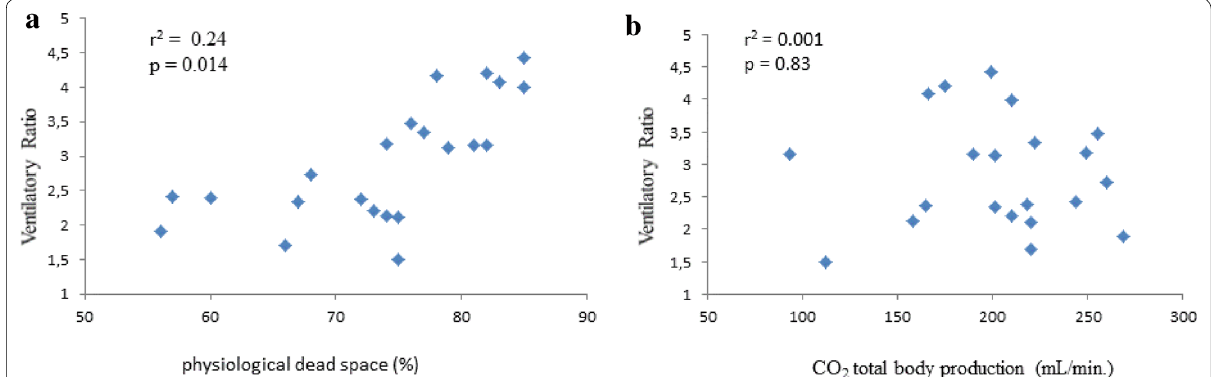
Fig. 1 Correlations between different respiratory parameters. a Correlation between physiological dead space and ventilatory ratio in 22 COVID‑19 ARDS patients studied early after intubation and initiation of protective ventilation. b Correlation between CO 2 total body production and ventilatory